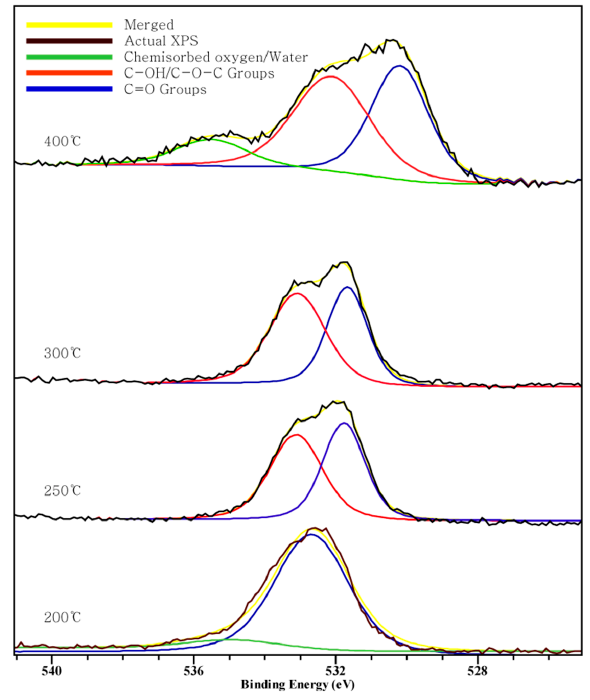
Figure 3. Oxygen 1s XPS spectra.